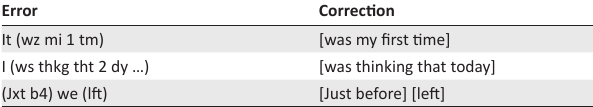
TABLE 3: WhatsApp language error use of numbers.